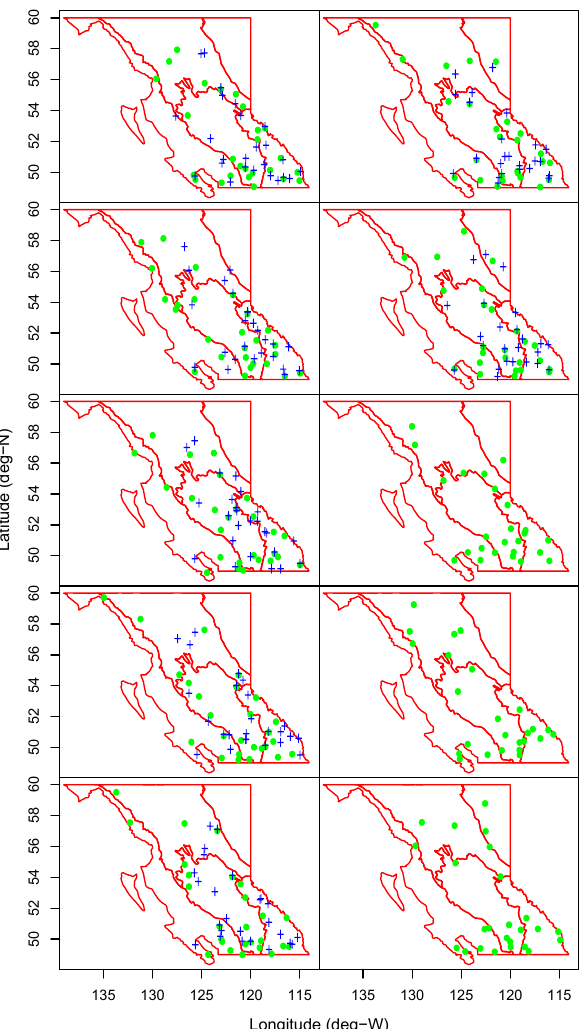
Figure 2. MSS station locations used in evaluating combination products. Green dots show the distribution of 10 test splits for com- paring means, MLRs, and ANNs to gridded SWE products through- out BC by cross-validation. Blue crosses show the distribution of seven test splits for comparing ANNs to VIC runs in four BC wa- tersheds. Physiographic regions are outlined in red.